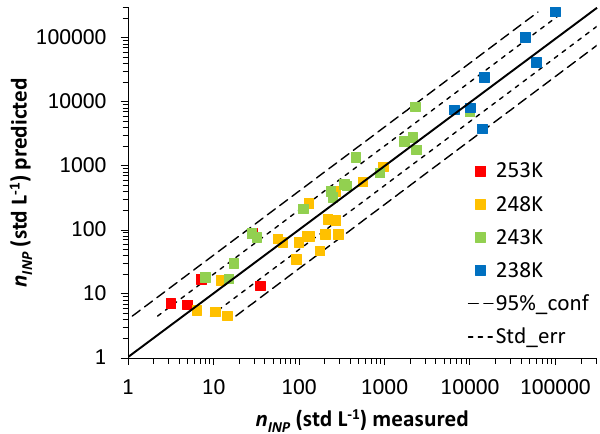
Figure 5. Relations between CFDC INP number concentrations measured at a nominal value of 105% RH w and n a > 0 . 5µm in labo- ratory (lab) and field (PACDEX and ICE-T) measurements of Asian (AD) and Saharan (SD) dust particles at temperatures of approxi- mately 253, 248, 243, and 238K. Dashed lines are not best fits for each temperature, but are instead determined from the empirical fit given by Eq. (2) (cf = 1, α = 0, β = 1.25, γ = 0.46, and δ =− 11.6). Uncertainties in observational data, given as twice the Poisson sam- pling error for the time-integrated samples, are shown by vertical error bars on data points. Note that at higher n INP these error bars are not visible beyond the plotted point size. Representative mea- sures of standard error in the predicted lines (see Fig. 6) are shown by capped error bars.